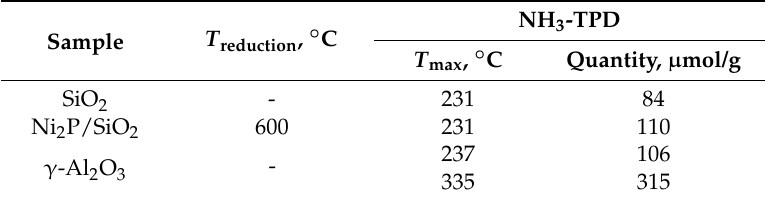
Table 2. The characteristics of Ni 2 P/SiO 2 catalyst, SiO 2 , and γ -Al 2 O 3 samples.